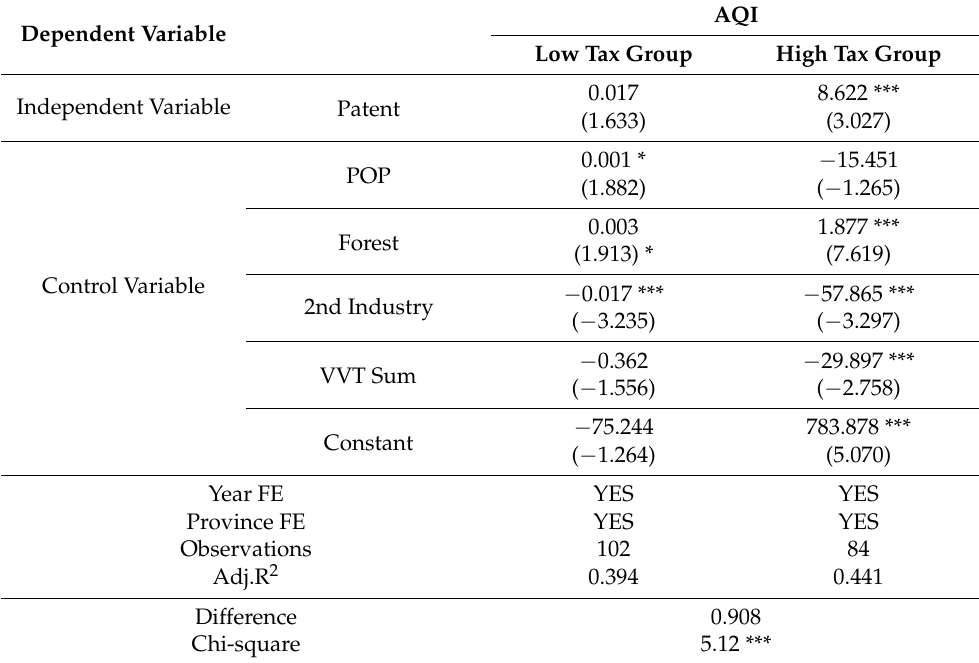
Table 7. VVT moderator effect test results in two groups.